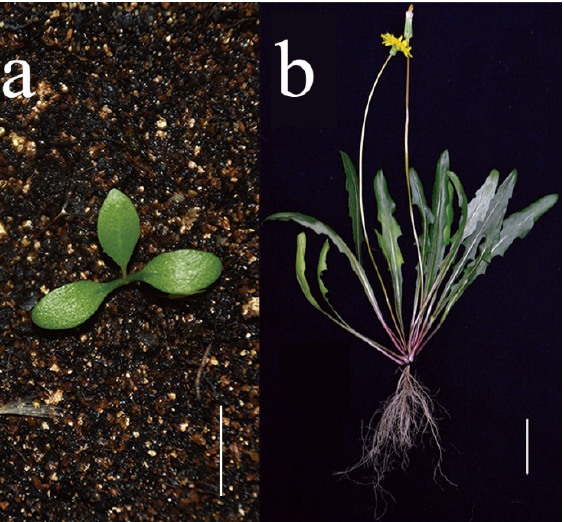
Figure 1 . Morphologies of Taraxacum kok-saghyz at different growth stages. ( a ) Morphologies of Taraxacum kok-saghyz at young leaves stage. Bar = 1 cm. ( b ) Morphologies of Taraxacum kok-saghyz at mature leaves stage. Bar = 5 cm.